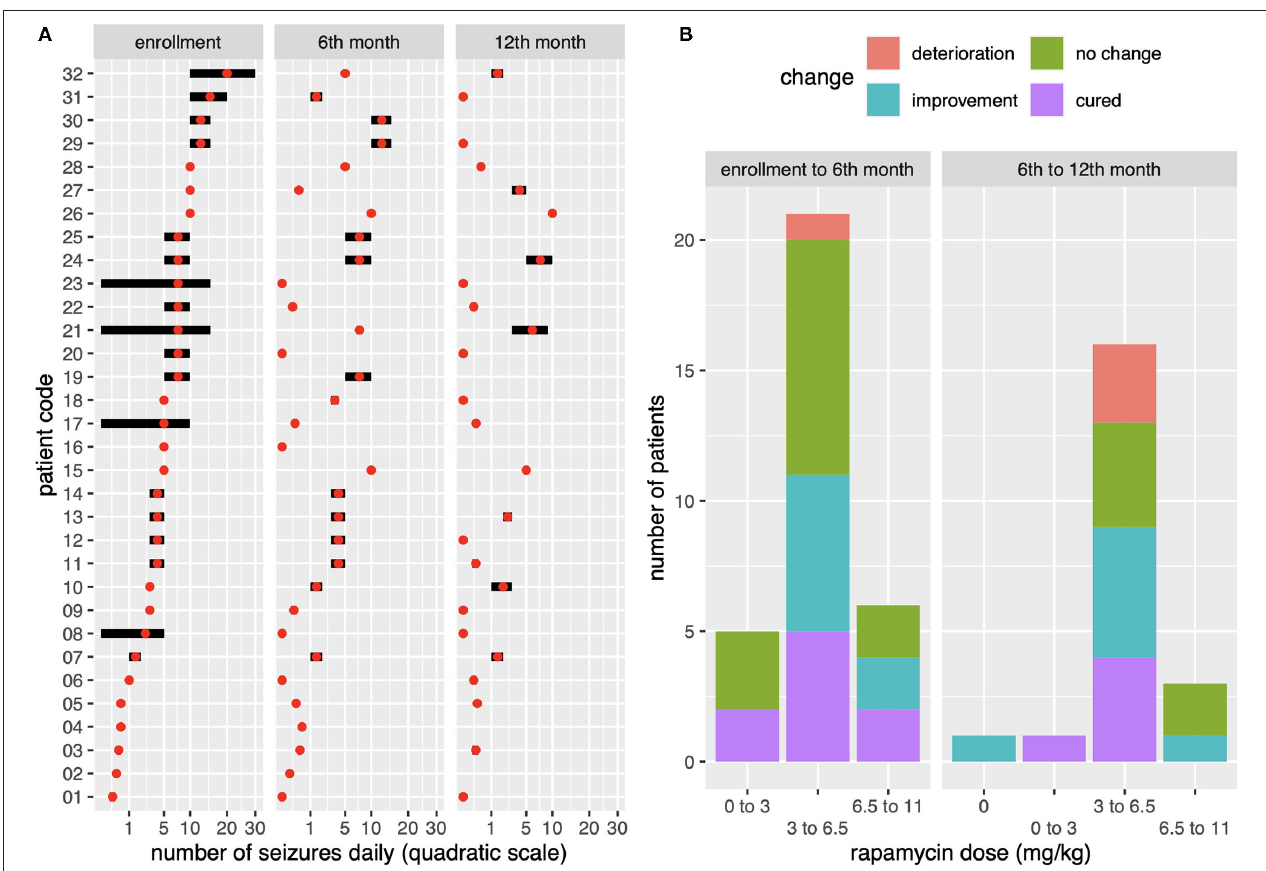
FIGURE 1 | (A) Presentation of changes in seizure dynamics in individual patients at baseline (A) and in consecutive semi-annual control points (B, C) on a quadratic scale (1a). Code symbols for individual patients on the vertical axis. On the horizontal axis, the daily seizure frequency is scaled in the range 0–5–10–20–30 seizures per day. The score marks correspond to the seizure frequency for each patient and illustrate the dynamics of treatment efficacy at 6 months and 1 year after rapamycin initiation. (B) rapamycin concentration distributions for the entire population studied in relation to the therapeutic effect obtained in first 6 months (AB) then after another 6 months (BC) that means after 1 year of rapamycin therapy. The achieved therapeutic effect, defined as improvement in seizure control, is compared to the taken dose of the drug per kg with the observed optimum in the range of 3–6.6